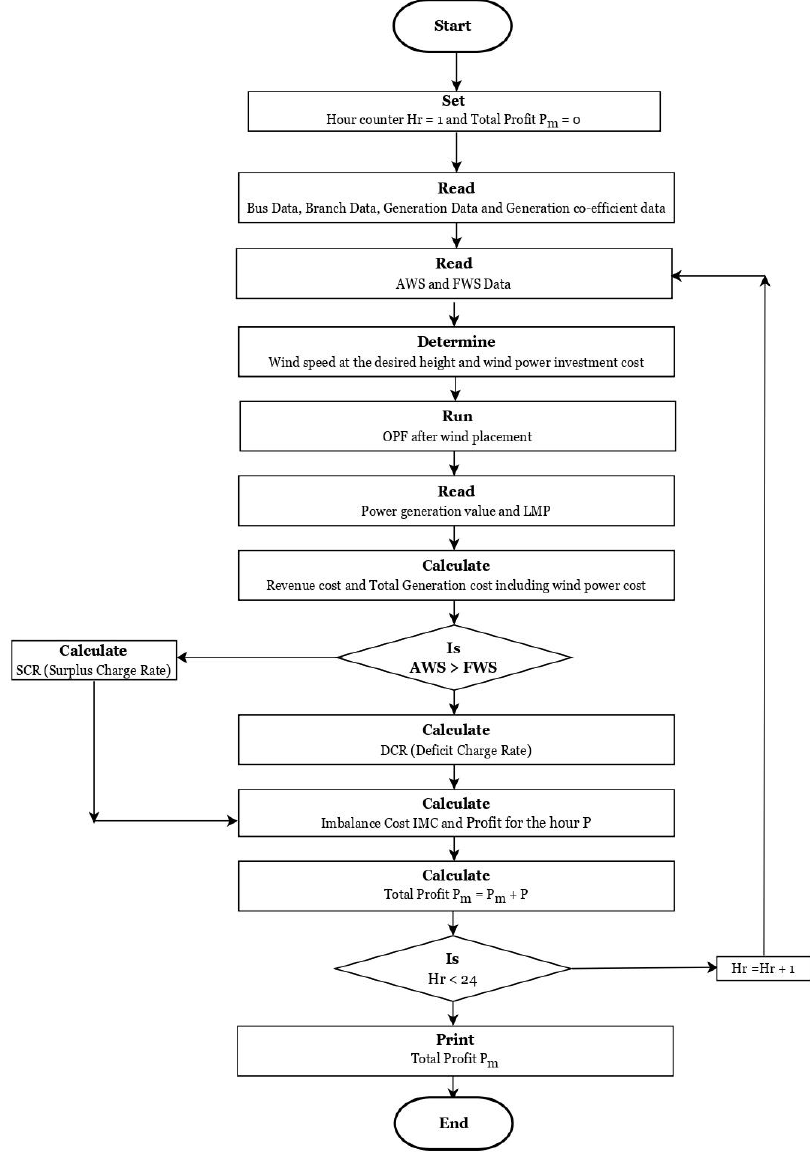
Figure 2. Flowchart of the presented method.